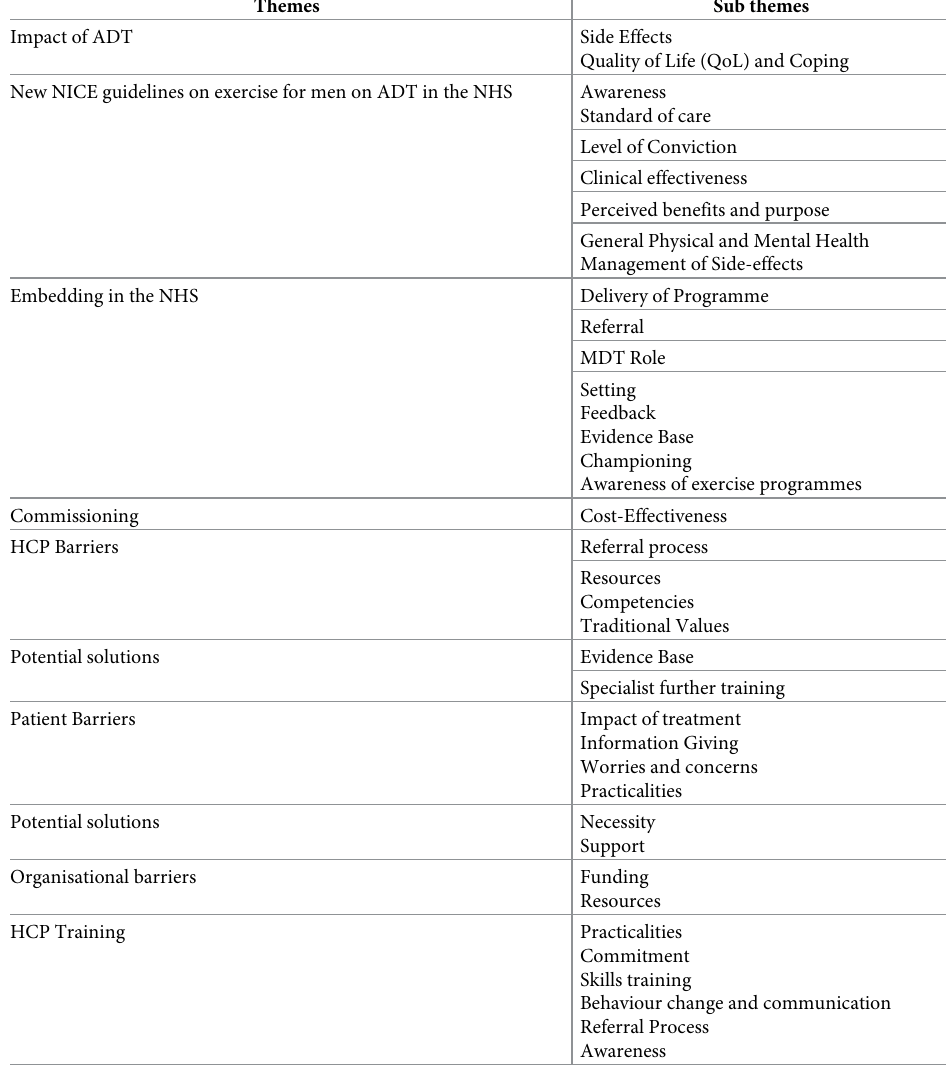
Table 4. All interview themes and